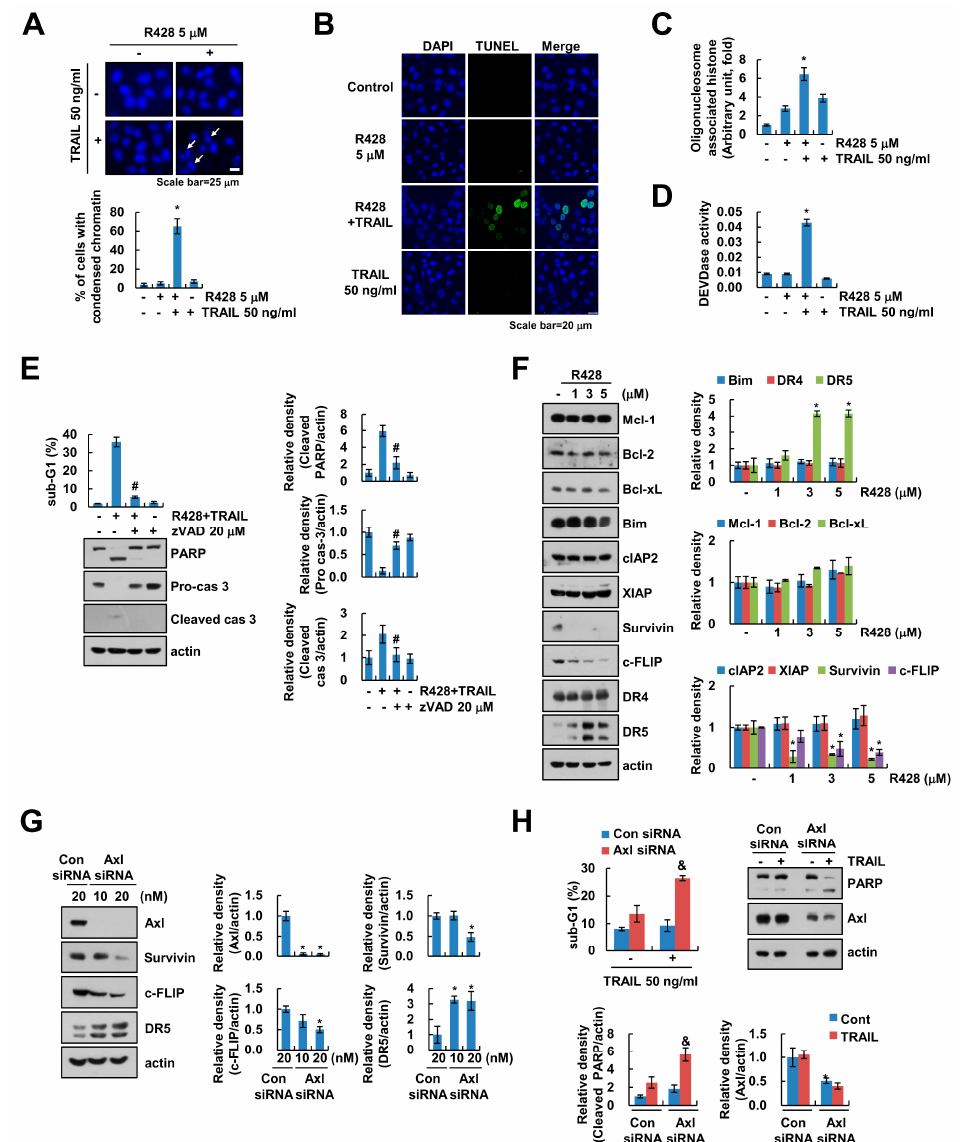
Figure 2. R428 increases caspase-dependent apoptosis through upregulation of DR5 expression and downregulation of c-FLIP and survivin expression. ( A – D ) Caki cells were treated with 5 µM R428 alone, 50 ng/mL TRAIL alone or R428 plus TRAIL for 24 h. DAPI staining ( A ), TUNEL staining ( B ), cytoplasmic histone-associated DNA fragments ( C ), and DEVDase (caspase-3) activity ( D ) were examined. Condensed chromatin rate determined by counting the number of apoptotic cells ( A ). ( E ) Caki cells were treated with 5 µM R428 plus 50 ng/mL TRAIL in the presence or absence of 20 µM z-VAD for 24 h. ( F ) Caki cells were treated with various concentrations of R428 for 24 h. ( G,H ) Caki cells were transfected with control (Con) or Axl siRNA for 24 h, and then cells were further incubated for 24 h ( G ) or were treated with 50 ng/mL TRAIL for 24 h ( H ). The sub-G1 population and protein expression were detected by flow cytometry ( E , H ) and Western blotting ( E – H ), respectively. The band intensity was quantified using Image J ( E – H ). The values in graph ( A , C – H ) represent the mean ± SEM of three independent experiments. * p < 0.01 compared to the control. # p < 0.01 compared to the R428 plus TRAIL. & p < 0.05 compared to the TRAIL in control